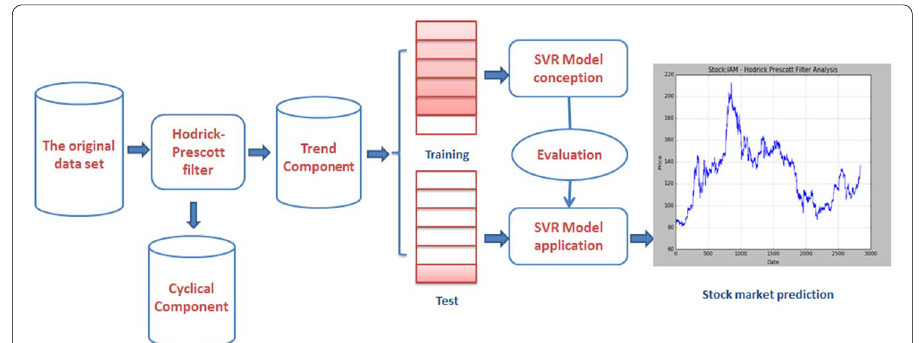
Fig. 3 Framework of stock price prediction using SVR model and HP